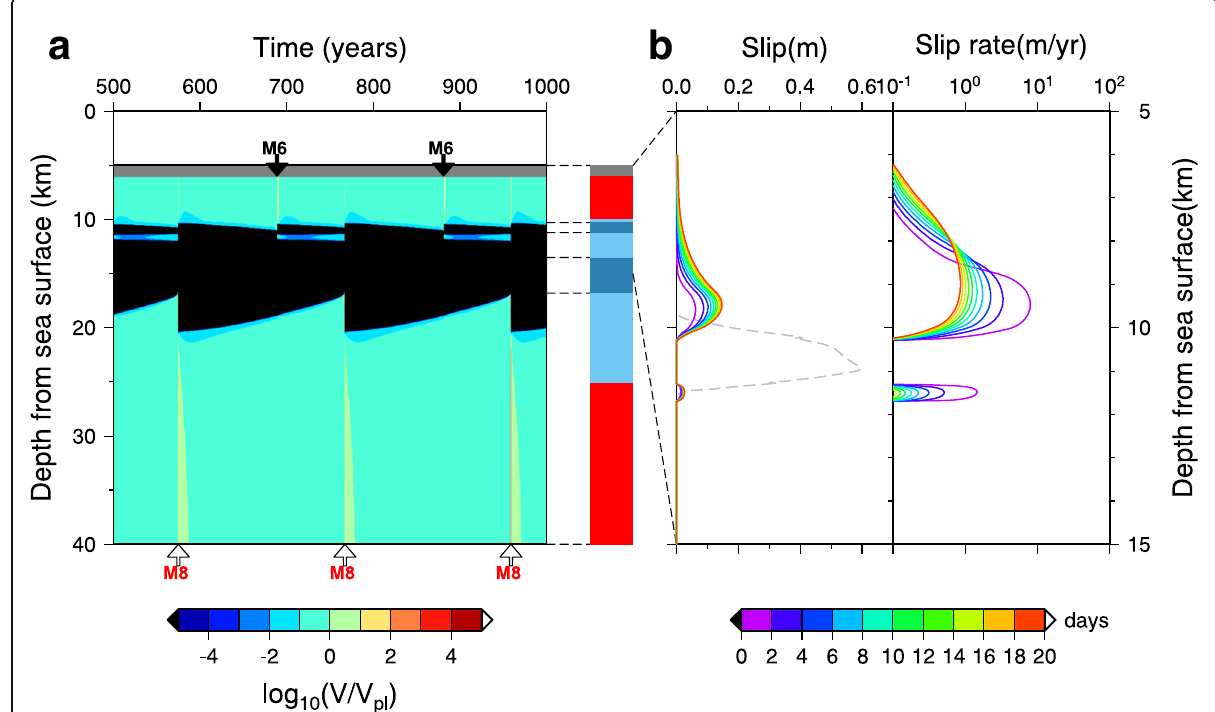
Fig. 7 Simulation result. a Spatiotemporal evolution of the slip rate V during the resultant earthquake cycles. Colors denote the slip velocity. Black region corresponds to strong coupling on the plate interface. Arrows denote occurrences of earthquakes with denoted magnitude. The vertical color bar in the middle panel denotes the depth distribution of ( a – b ) σ eff . b Depth distributions of postseismic slip and slip rate just after the occurrence of a M6 earthquake indicated by solid arrows in a . Cumulative slip and slip rate profiles are shown in the left and right side panels, respectively. Colors of lines indicate days after the M6 earthquake. The broken gray line represents the coseismic slip distribution of the M6